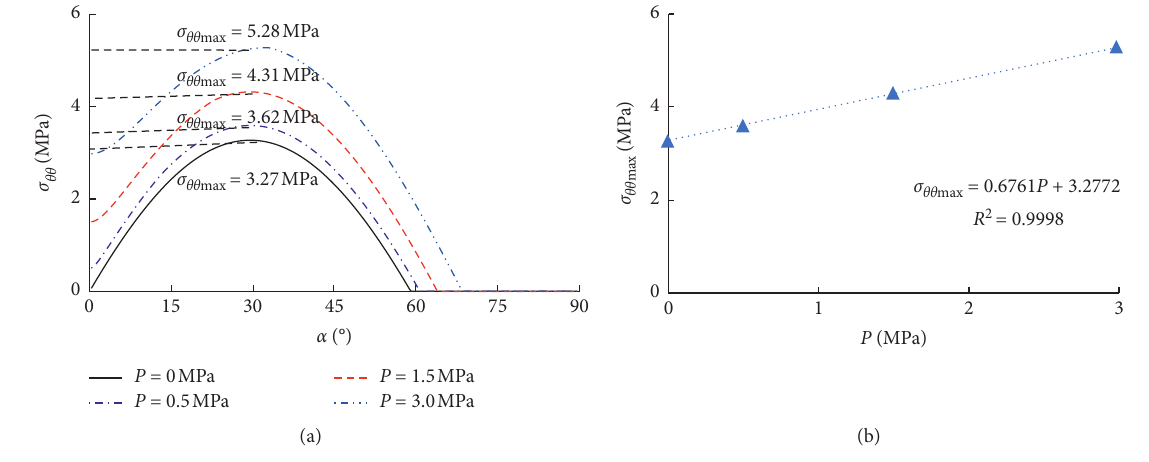
Figure 6: Effect of gas pressure on maximum circular